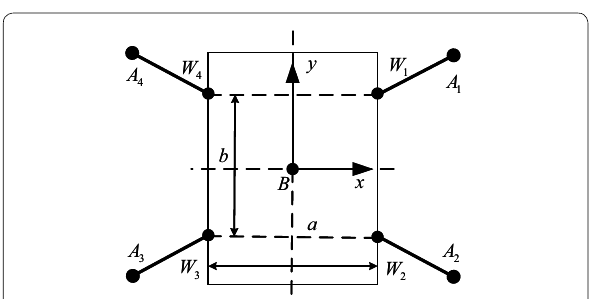
Figure 9 Projection diagram of the robot in chassis